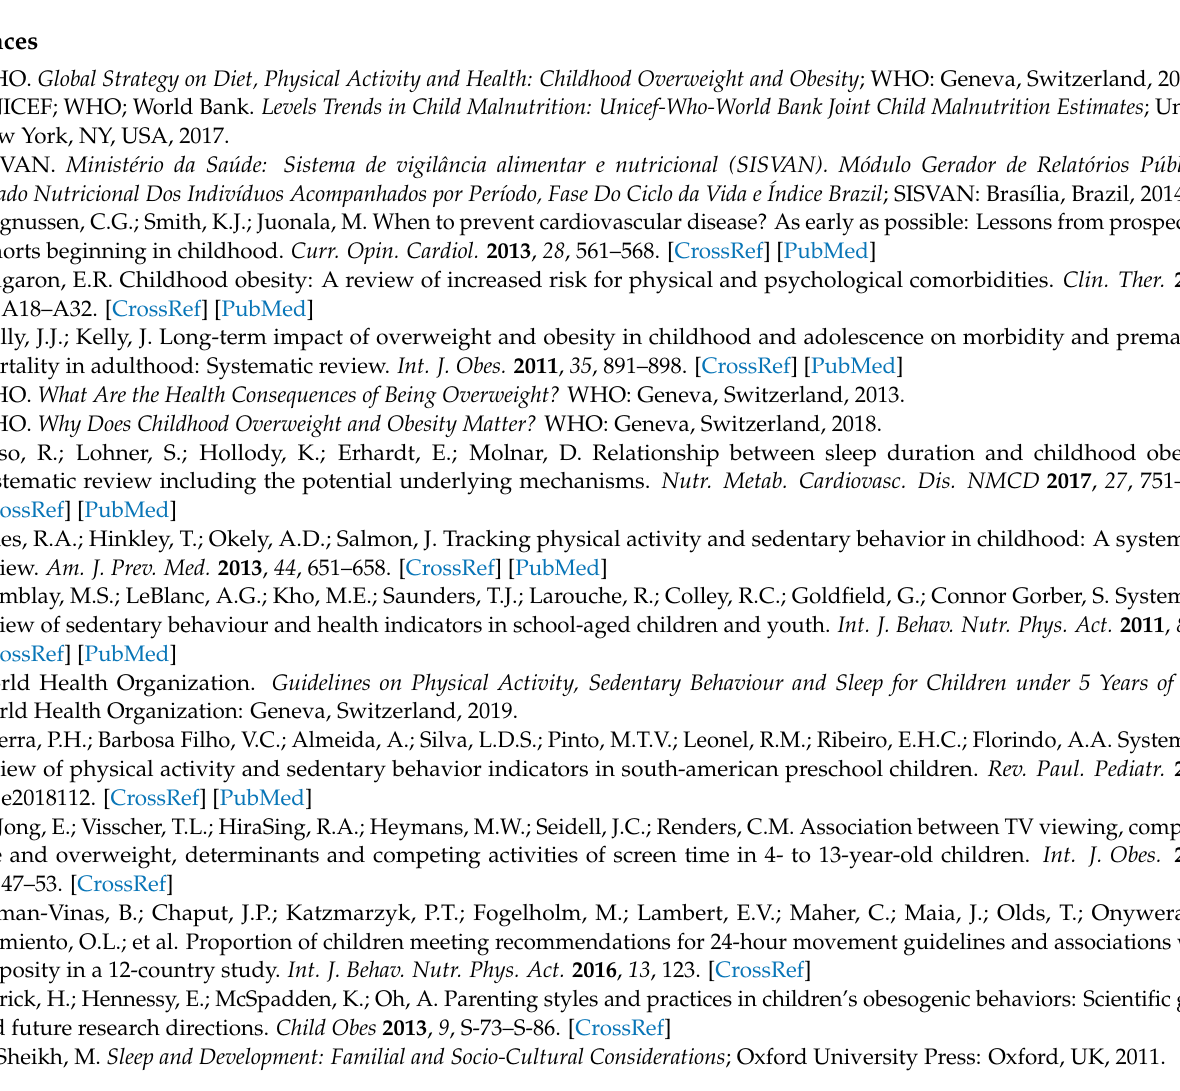
Supplementary File 2: Portuguese version of the measurement scales, Supplementary File 3: